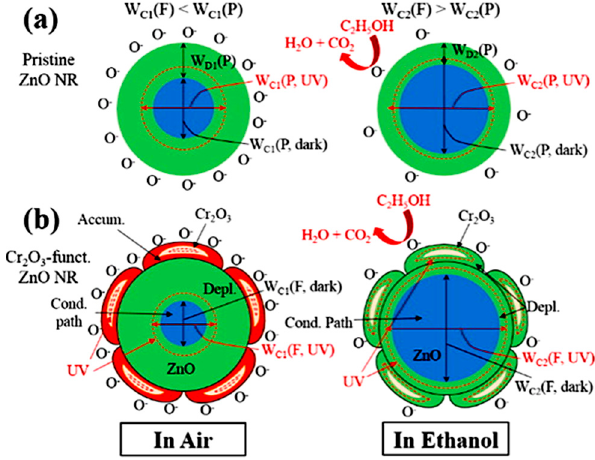
Figure 4. Schematic diagrams: ( a ) pristine ZnO NW; ( b ) Cr 2 O 3 -modified ZnO NW in the dark and under UV illumination in air and ethanol showing the depletion layer and conduction path.